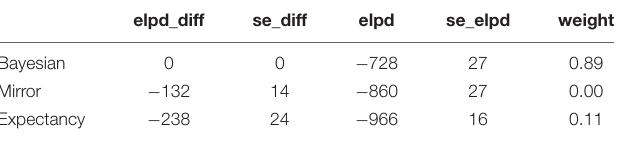
TABLE 7 | Model comparison, Experiment 1.